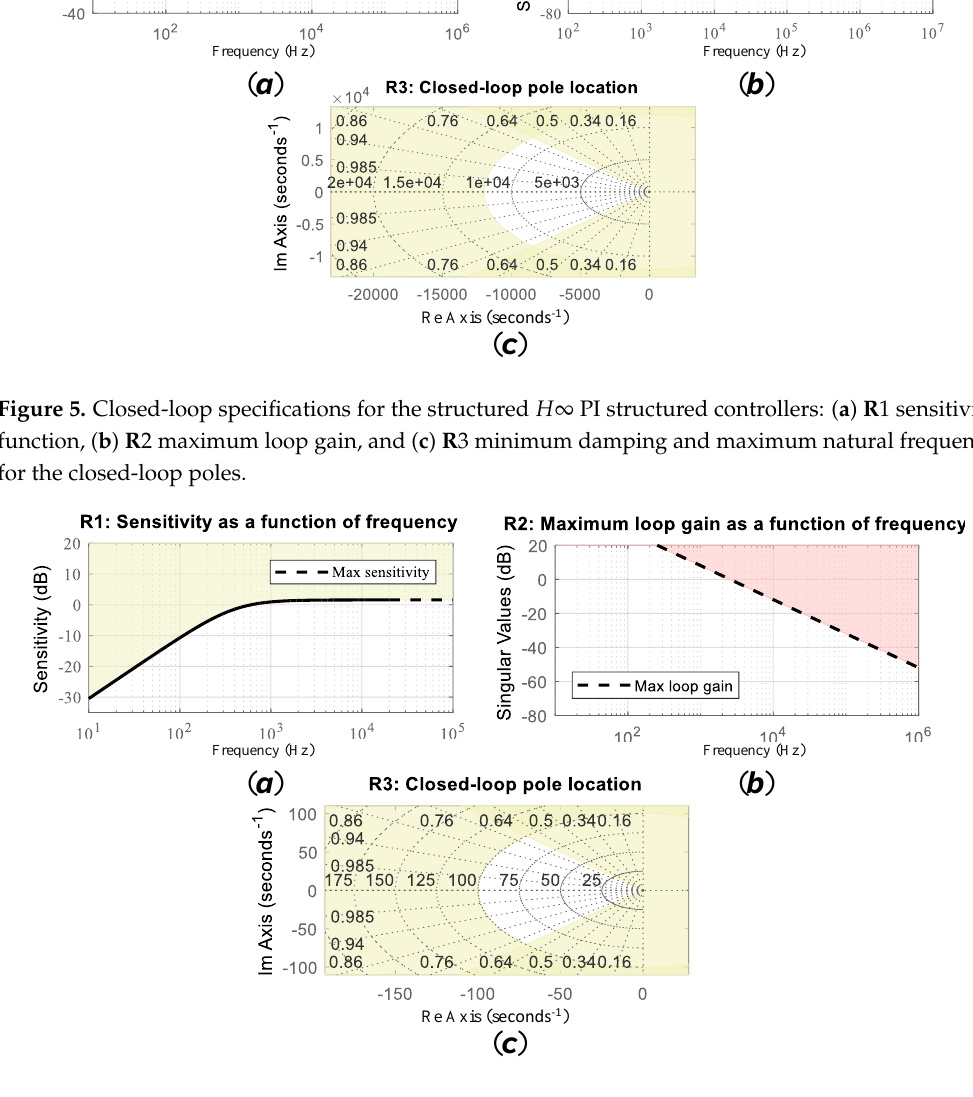
Figure 6. Closed-loop specifications for the structured H ∞ DC-link PI structured controller: ( a ) R 1 sensitivity function, ( b ) R 2 maximum loop gain, and ( c ) R 3 minimum damping and maximum natural frequency for the closed-loop